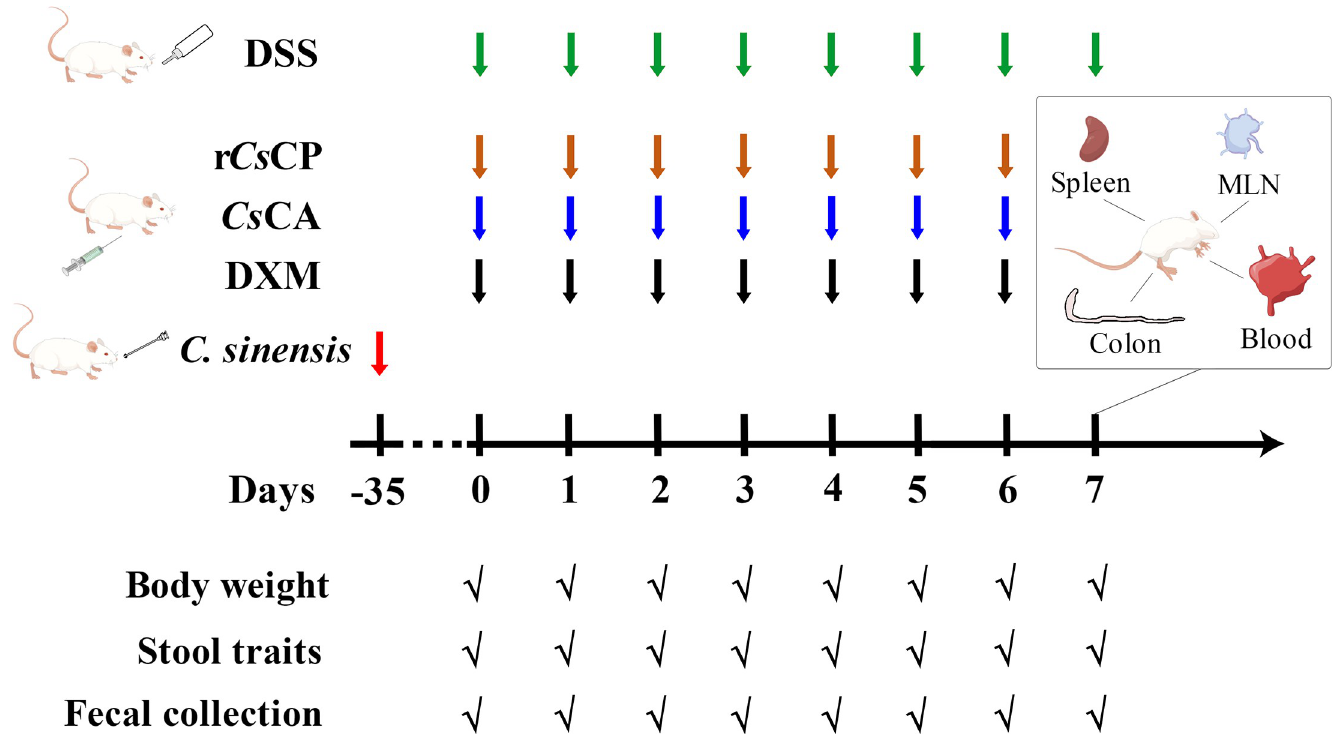
Fig 1. Schematic diagram of DSS-induced colitis and treatment in